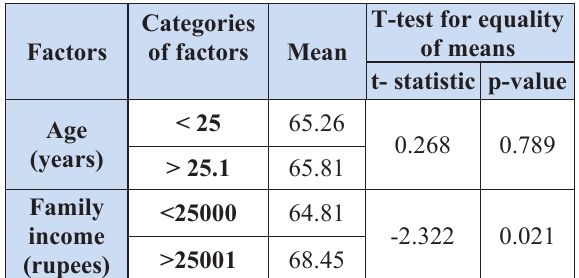
Table-3: T-test for age and family income